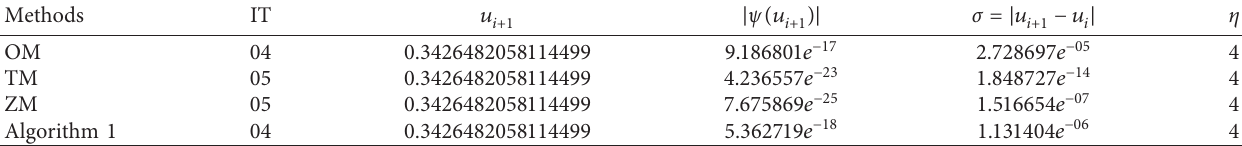
Table 1: Comparison among different fourth-order